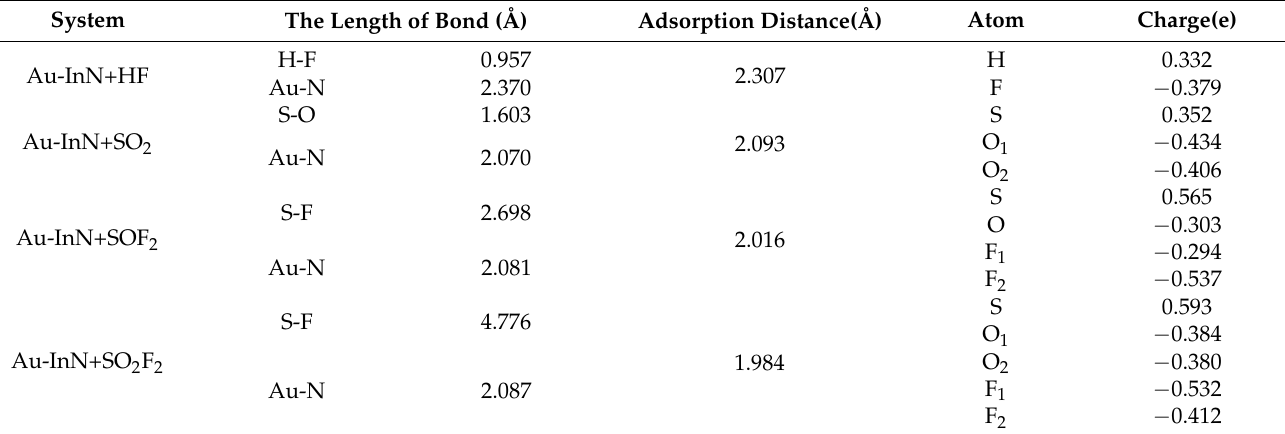
Figure 4. The steadiest adsorption configuration of gas on Au-InN monolayer and the DCD of this configuration: ( a ) HF, ( b ) SO 2 , ( c ) SOF 2 and ( d ) SO 2 F 2 adsorption system. The length of Au-N bond is shown in black. Table 3. The characteristic parameters of HF, SO 2 , SOF 2 and SO 2 F 2 adsorption